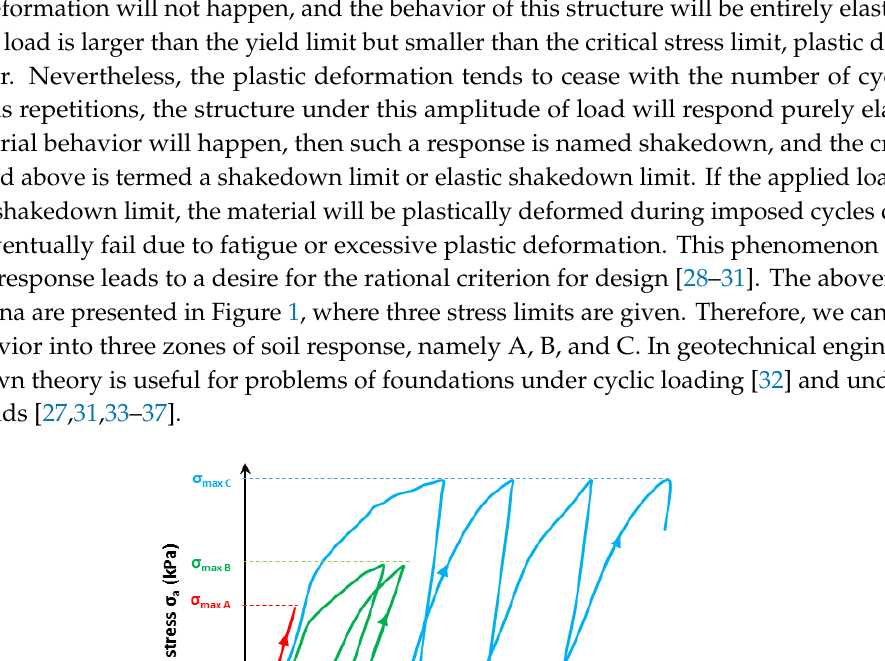
Figure 2. Soil respond to repeating loading in strain-controlled test ( a ) and stress-controlled test ( b ).